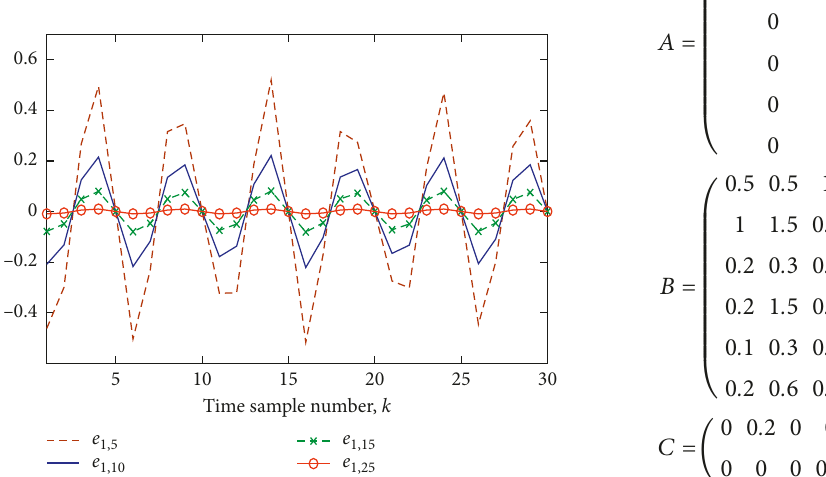
Figure 6: Terminal tracking errors e number j .